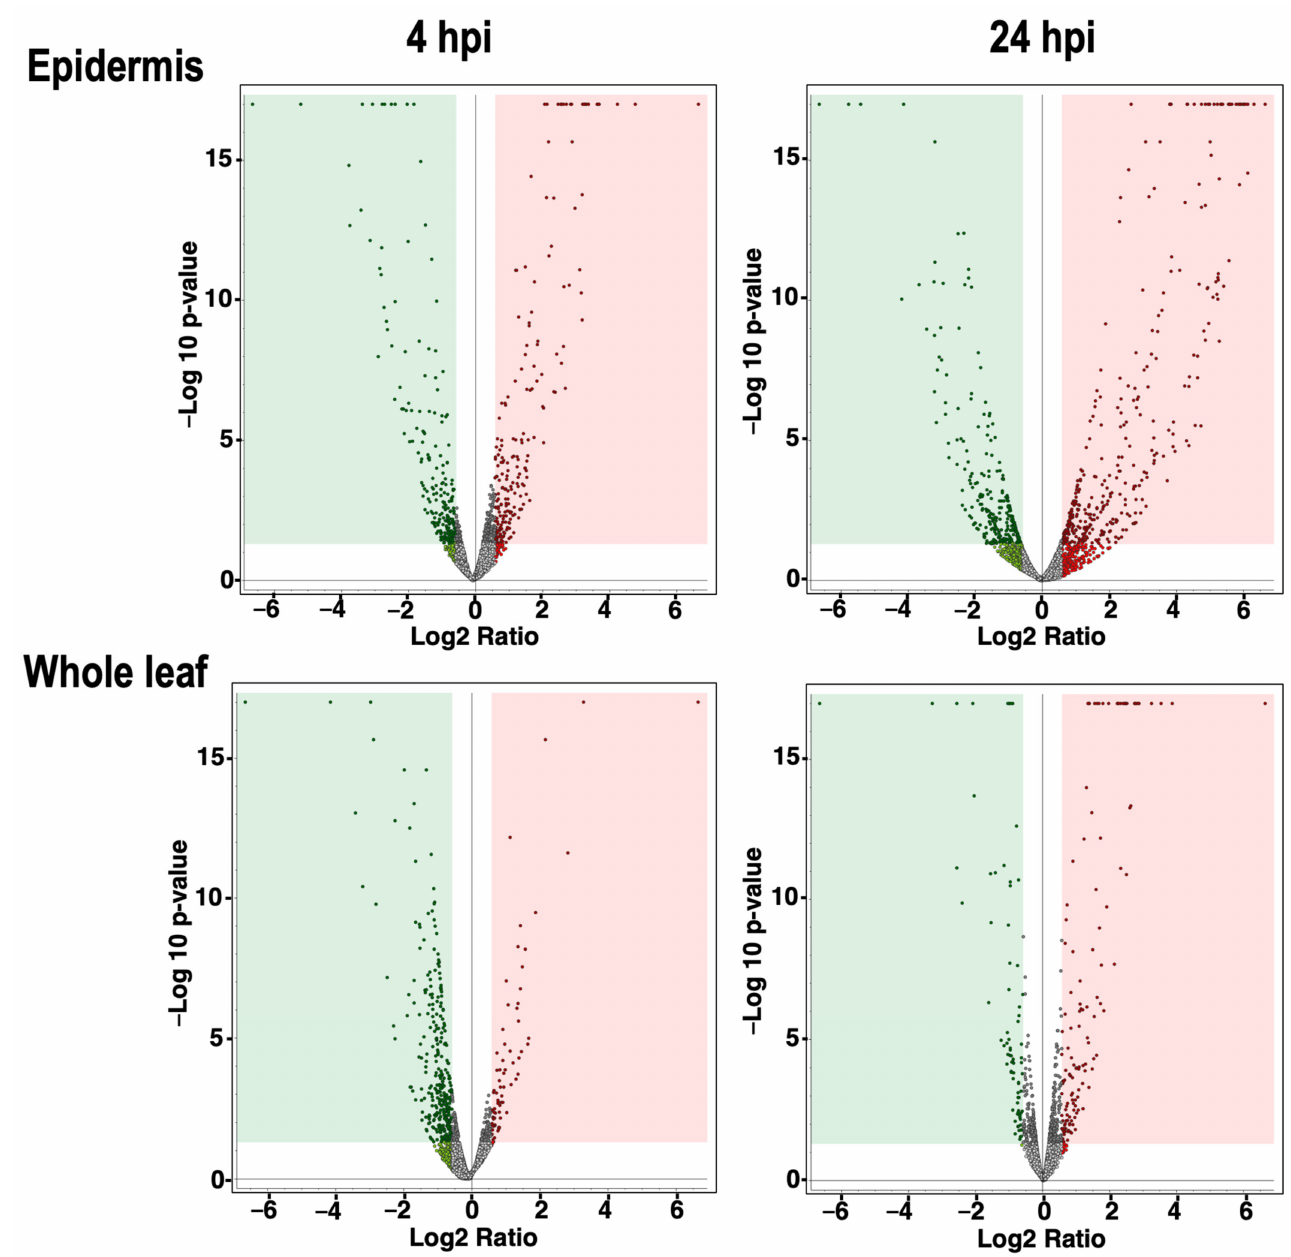
Figure 3. Volcano plots illustrate the spread of quantified proteins in the leaf epidermis inoculated by F. graminearum . The plots show the distributed proteins at 4 hpi and 24 hpi of the leaf epidermis. Expression pattern of proteins in the whole leaf at 4 hpi and 24 hpi was also measured. The vertical axis is − log10 of the p-value (cutoff value 0.05), whereas the horizontal axis is log fold change (cutoff value 1.5). The dots indicate all the identified proteins in this experiment. Red and green square areas represent the significantly up-regulated and down-regulated proteins,